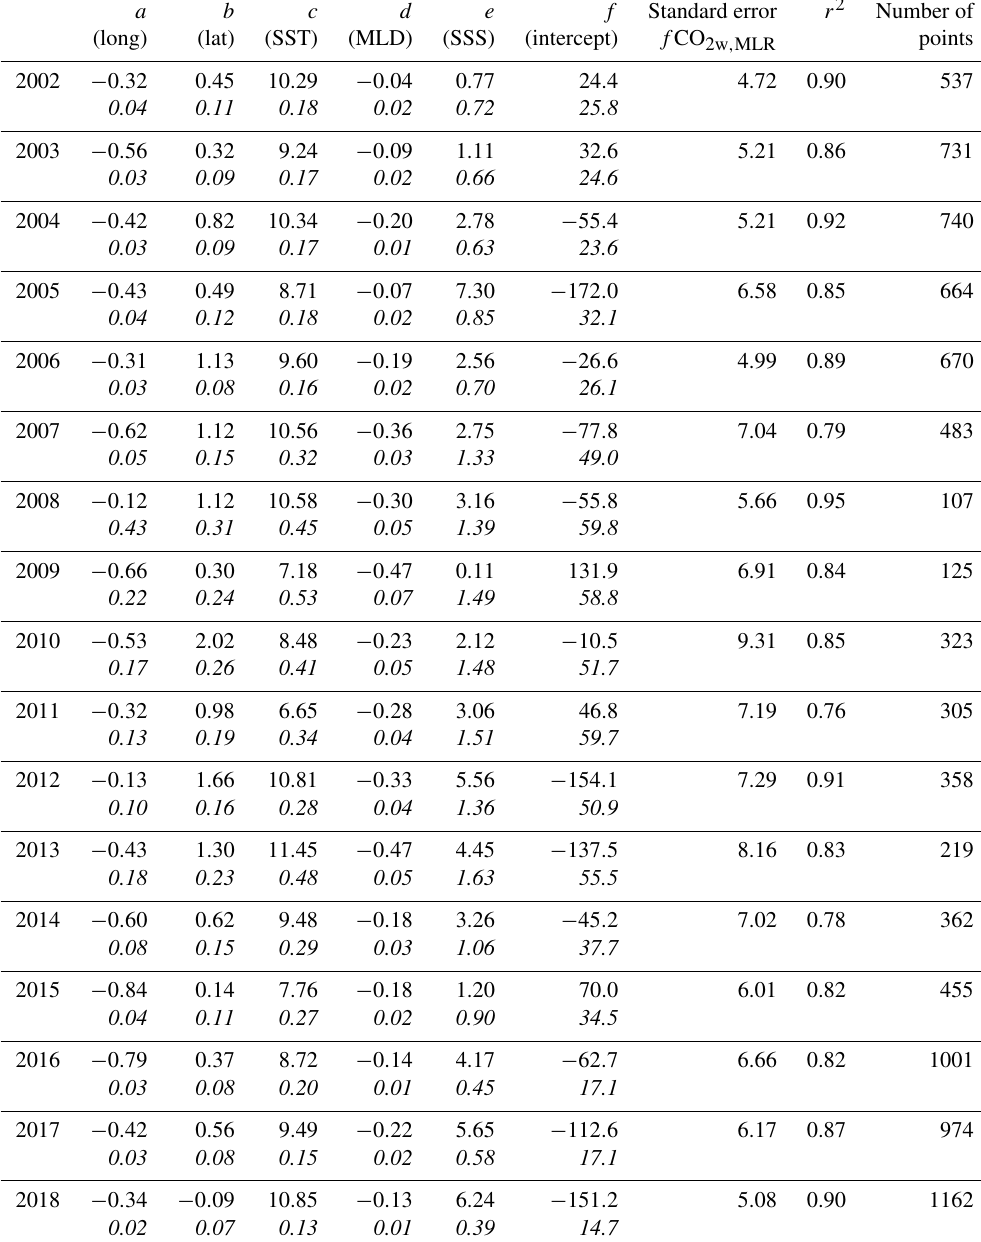
Table 1. Coefficients for the MLR for each year ∗